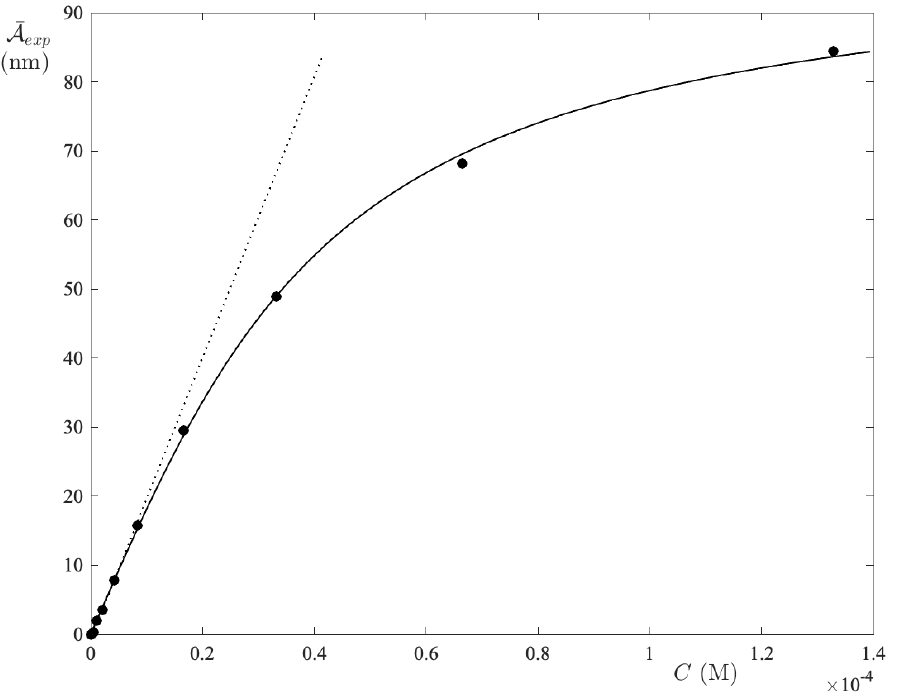
Figure 1. Absorption spectra recorded in the FS − UPW binary system as the dye concentration varies. The band interval indicates the range used to calculate the integral absorbance